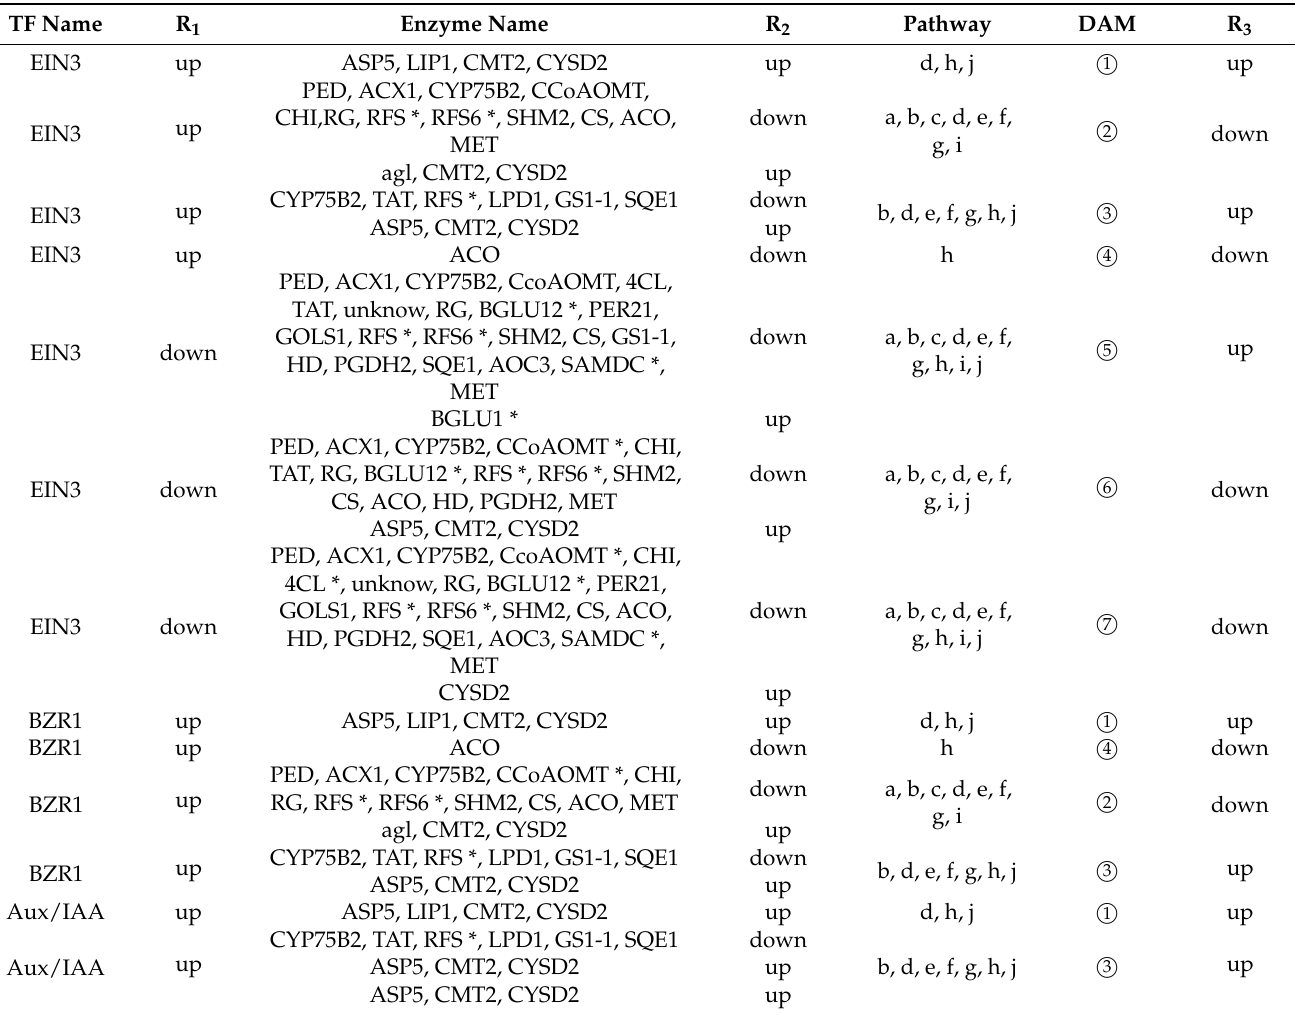
Table 3. Regulations of DEG(TF)s to DAMs via 10 common metabolic